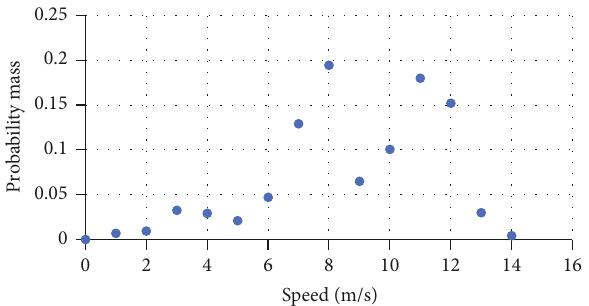
Figure 8: Average pmf for the speed at the null class